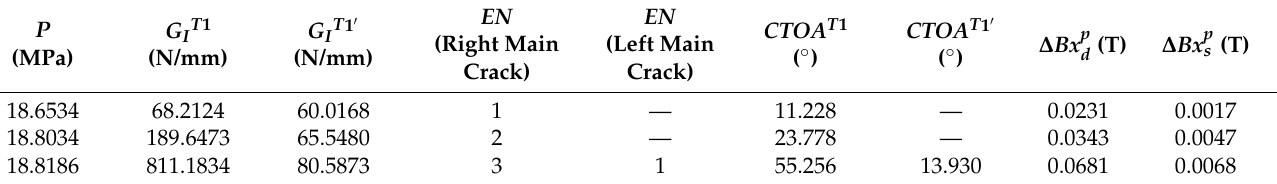
Figure 8. Component curve of the magnetic induction intensity component under 18.8186 MPa load step. Table 4. Relevant feature quantities in the crack propagation process.